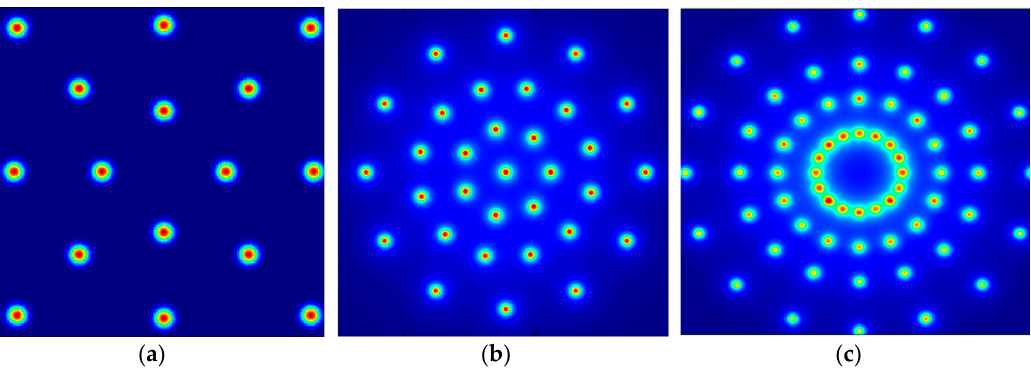
Figure 2. The conceptual diagram of a geometric shaping (GS)-QAM-based communication system.